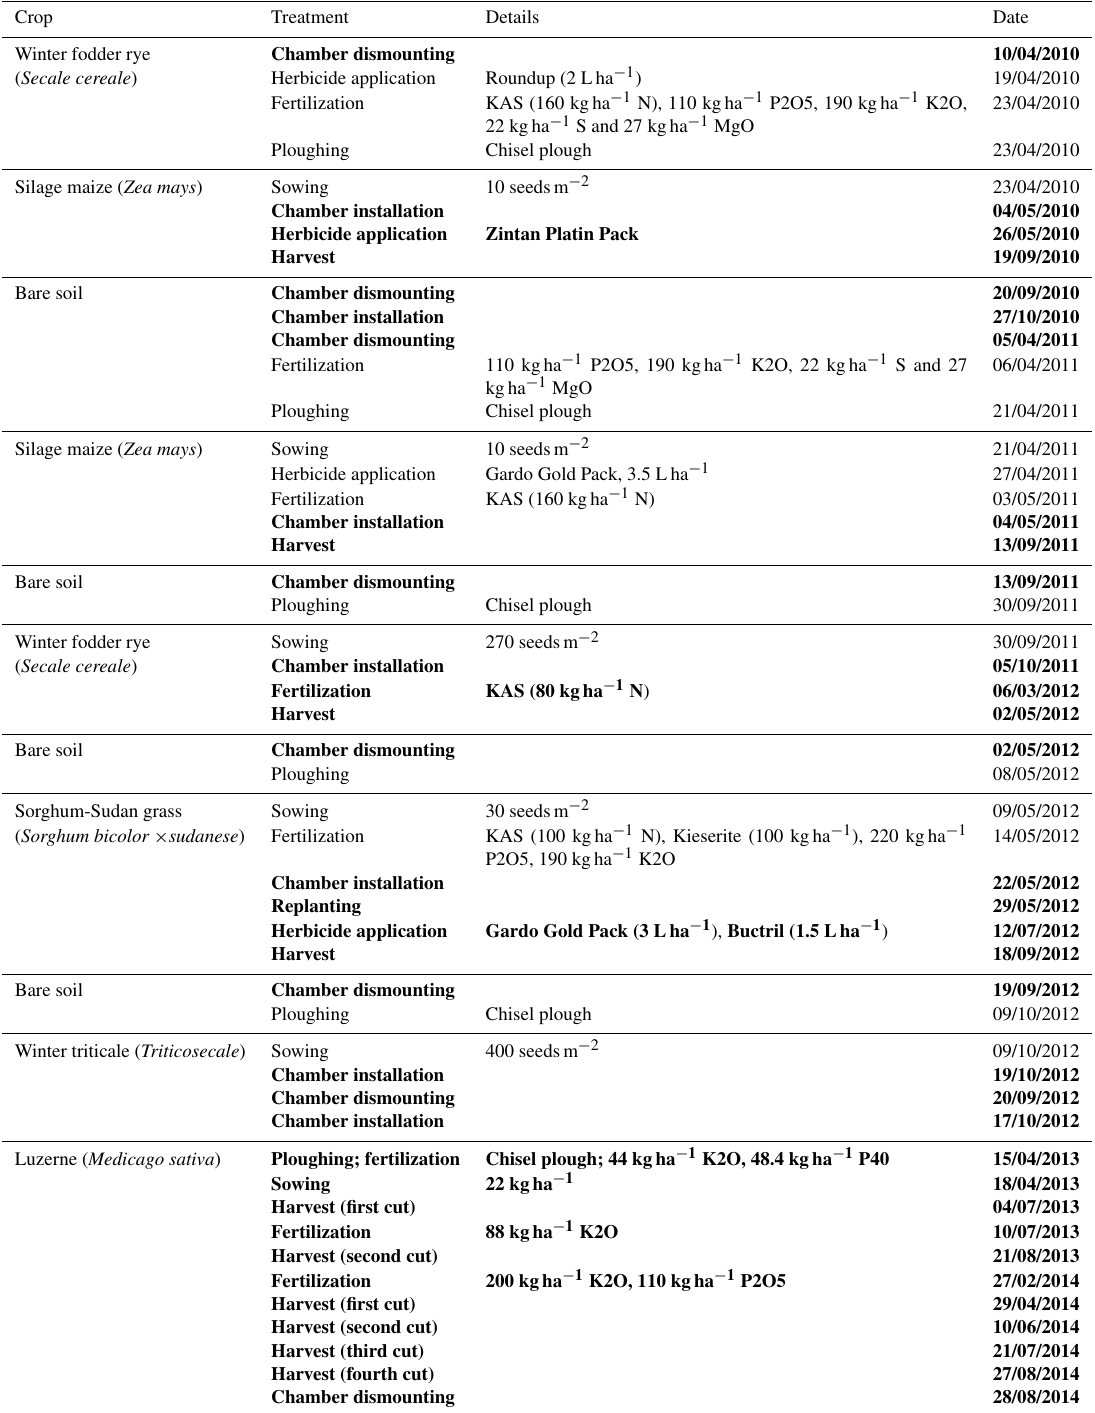
Table A1. Management information regarding the study period from 2010 to 2014. Bold rows indicate coverage by chamber measurements.